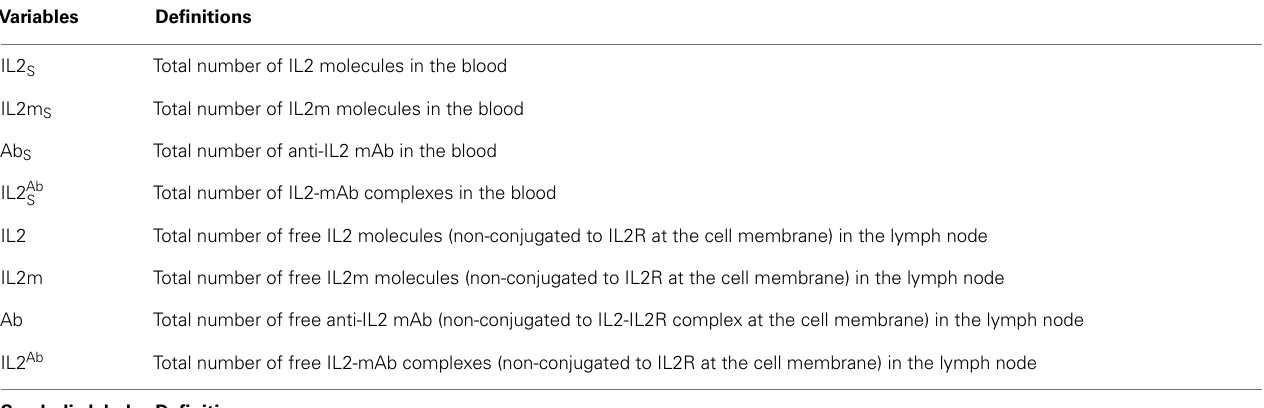
Table 1 |Variables and parameters appearing in the equations that model the dynamics in the blood